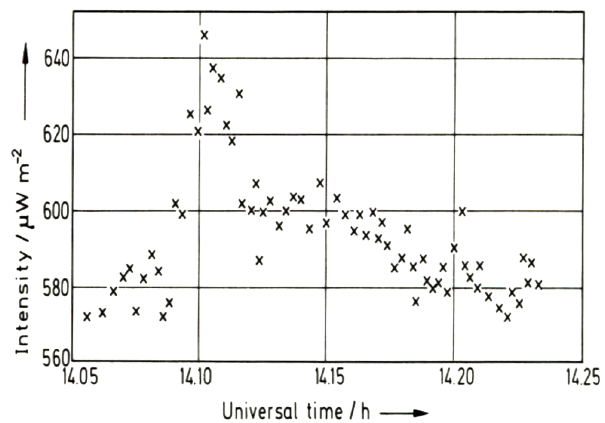
Figure 17. Recording of the He II emission line at 30.4nm aboard